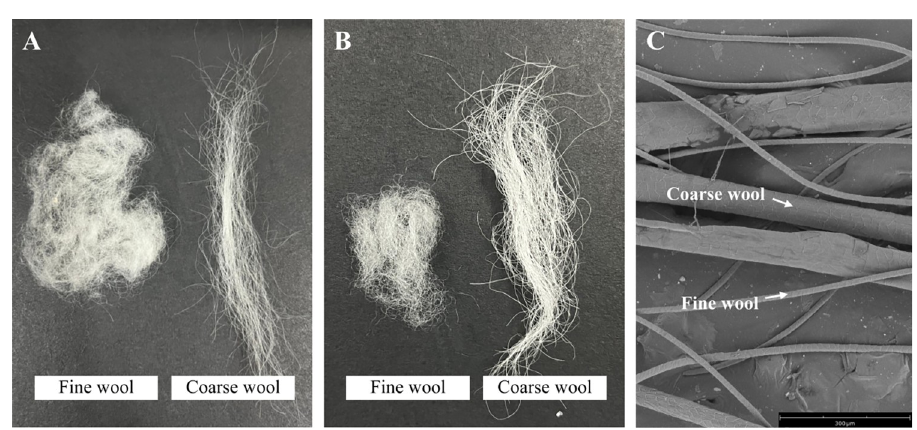
Fig 1. Wool characterization of the Hetian sheep based on the high and low wool density. ( A ) The wool samples of the HS. ( B ) The wool samples of the HP. ( C ) Microstructure of fine wool and coarse wool.